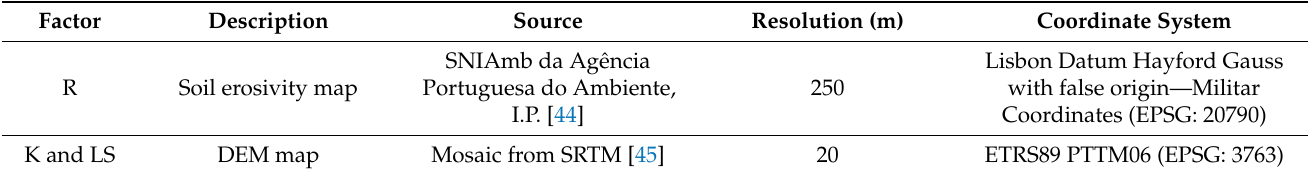
Table 3. Data sources used to create each factor (R, K and